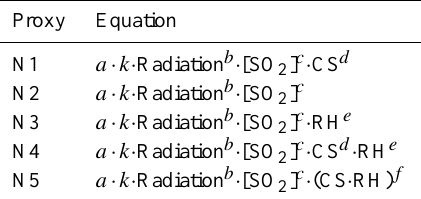
Table 5. Nonlinear proxies.